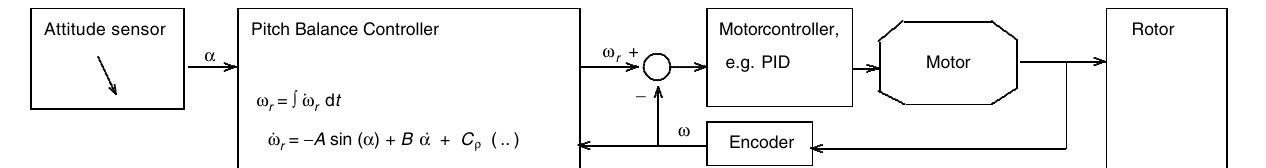
Figure 5 Scheme for the pitch balance controller: The controller uses information about the pitch angle of the robot and the encoder values from the rotor as input, giving α as the output (e.g., gyroscope and gravity sensor combination). The parameters A , B and C have to be adapted to the properties of the robot. PID indicates proportional-integral-derivative controller. 241 C (cid:1) Woodhead Publishing Ltd